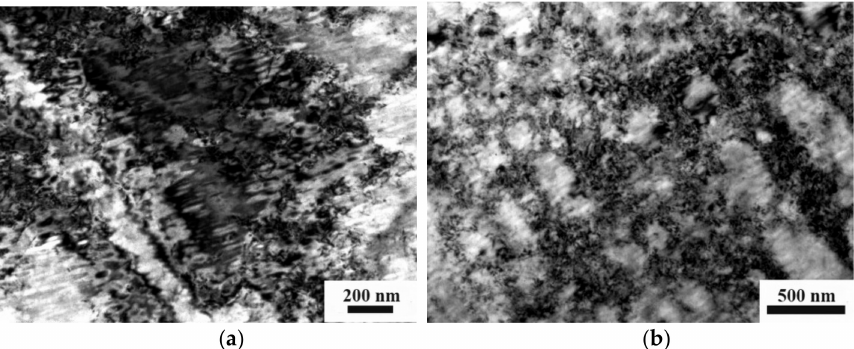
Figure 7. TEM images of the microstructure of the TWIP steel processed by warm rolling at tempera- tures of 375 ◦ C ( a ) and 500 ◦ C ( b ).